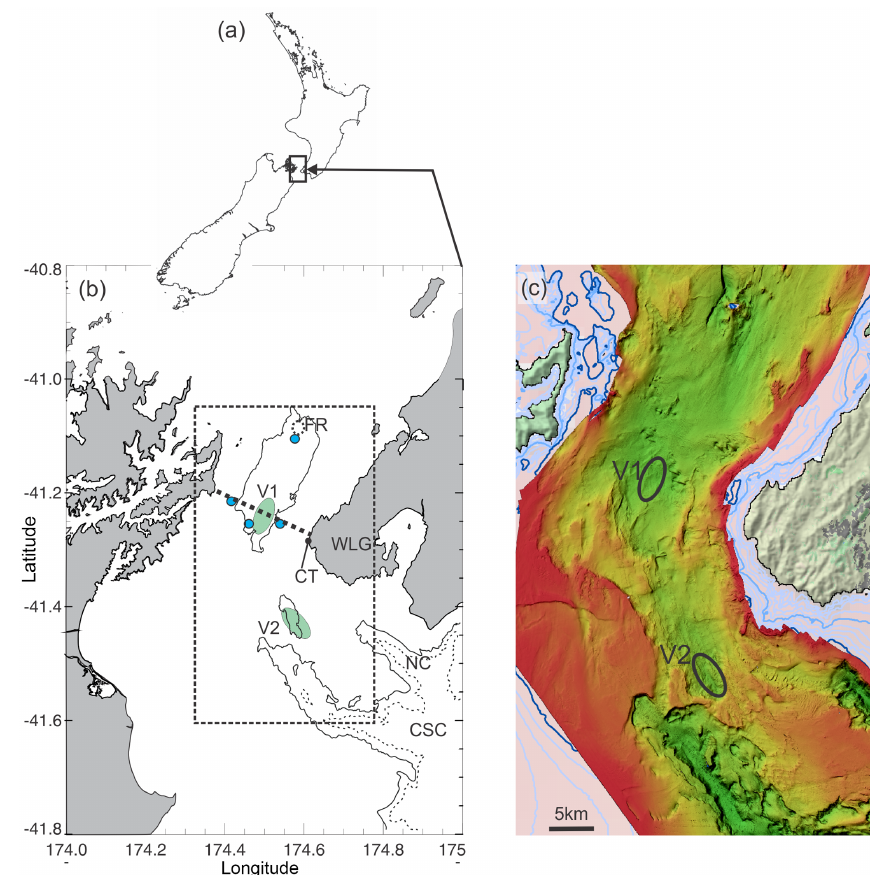
Figure 1. Location showing (a) New Zealand and, within this, (b) Cook Strait Narrows is bounded by Cape Terawhiti (CT) to the east and the headlands of the (shaded) Marlborough Sounds to the west and with the Cook Strait and Nicholson Canyon to the south (CSC and NC). The 200 (solid) and 400m (dashed) depth contours are marked, as well as the shoal at Fishermans Rock (FR). ADCP moorings are marked with blue circles. The microstructure data come from profile regions V1 and